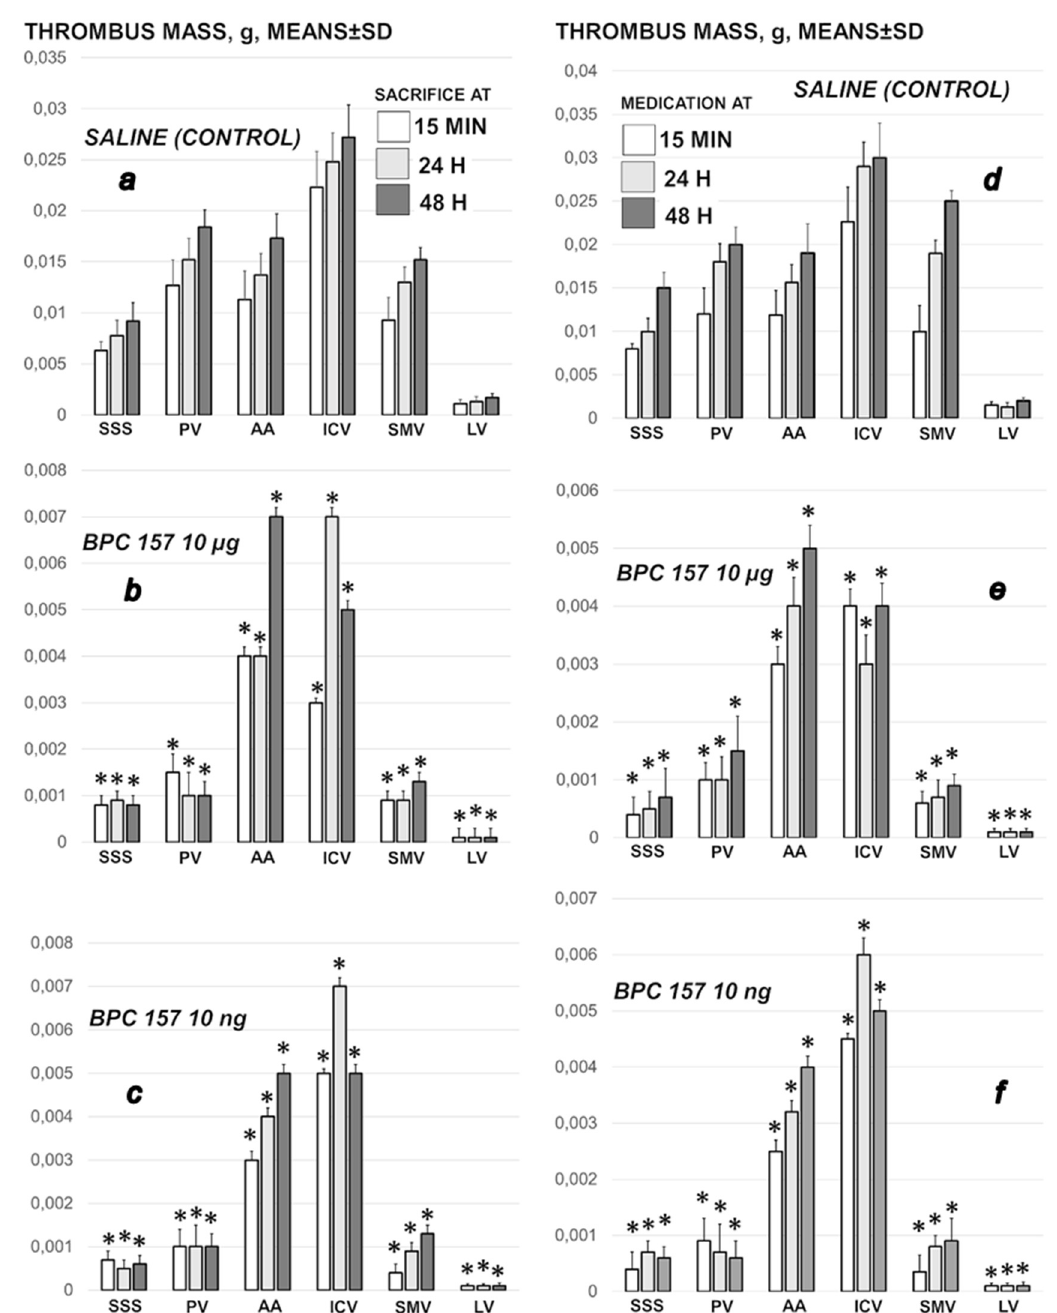
Figure 6. Thrombus presentation in the rats with ligated superior sagittal sinus in the superior sagittal sinus (SSS), portal vein (PV), abdominal aorta (AA), inferior caval vein (ICV), superior mesenteric vein (SMV) and lienal vein (LV) at the end of the 5 min assessment following medication (BPC 157 10 µg/kg, 10 ng/kg; saline 5 mL/kg) given intraperitoneally. Left: Early medication at 1 min ligation time, blood pressure assessment before sacrifice at 15 min, 24 h and 48 h ligation time ( a – c ). Right: Delayed medication at 15 min, 24 h and 48 h ligation time ( d – f ). Similar effects were obtained with BPC 157 intragastric or local application at the swollen brain (data not specifically shown). Means ± SD, * p ˂ 0.05, at least vs. control.